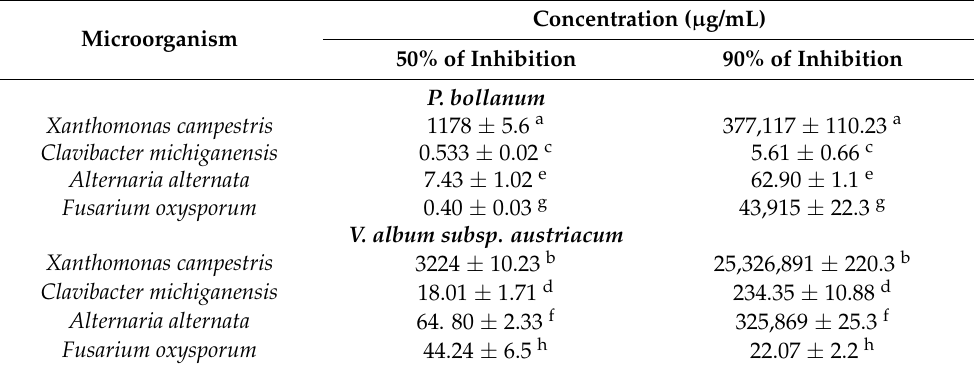
Table 5. Estimation of concentrations of 50% (IC 50 ) and 90% (IC 90 ) of microorganism inhibition for aqueous extracts obtained from P. bollanum and V. album subsp. austriacum (standard deviations are shown).